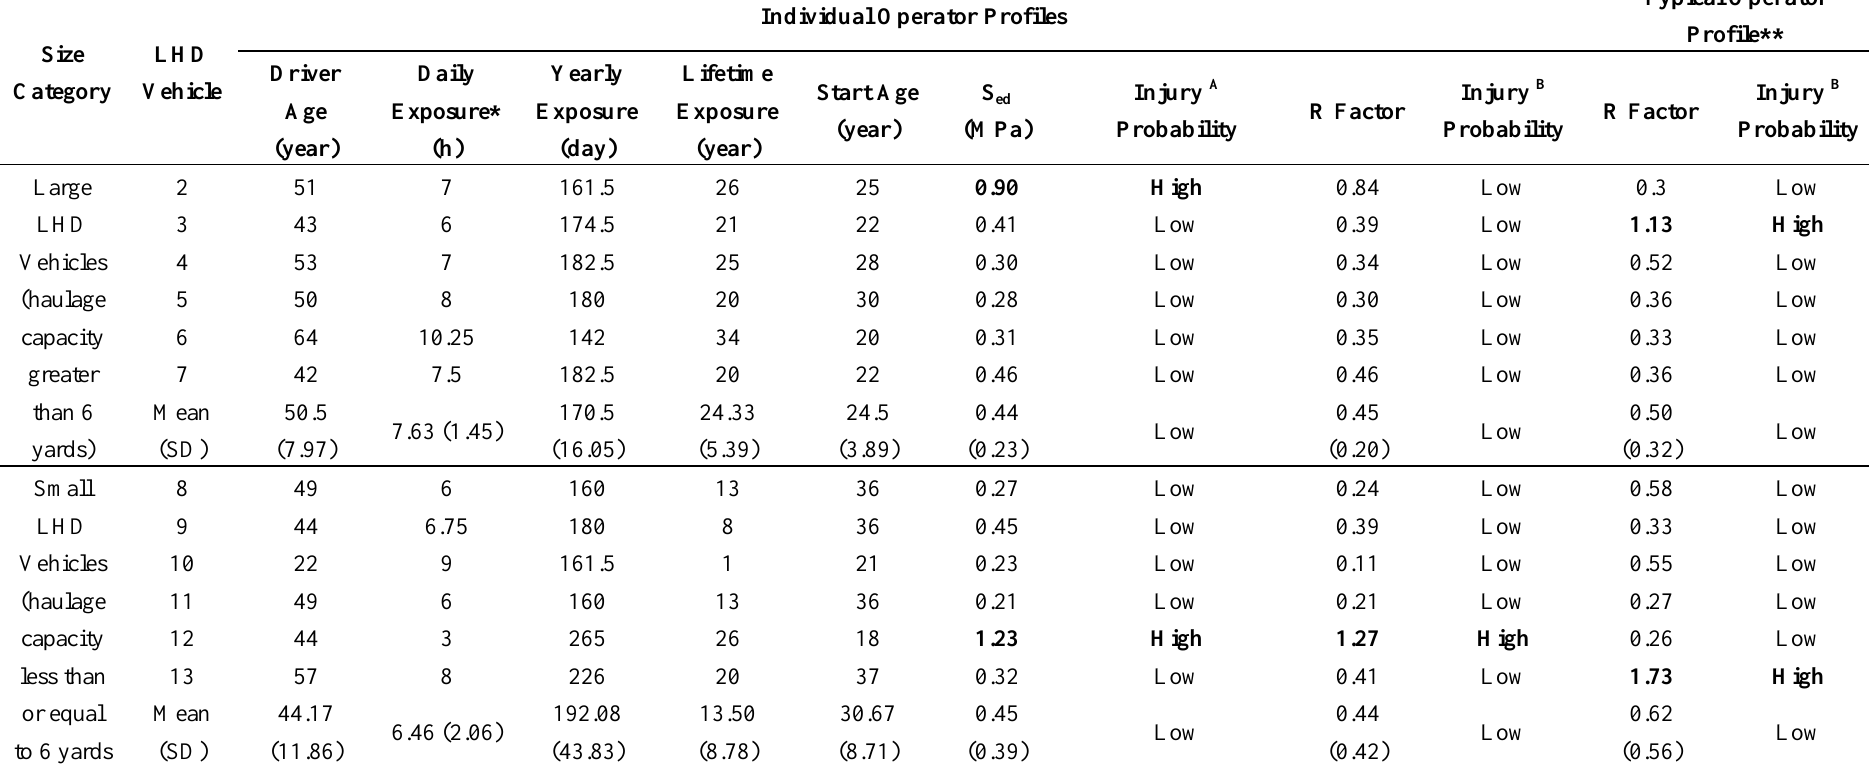
Table 5. Evaluation of health risks associated with vibration containing multiple shocks (ISO-2631-5